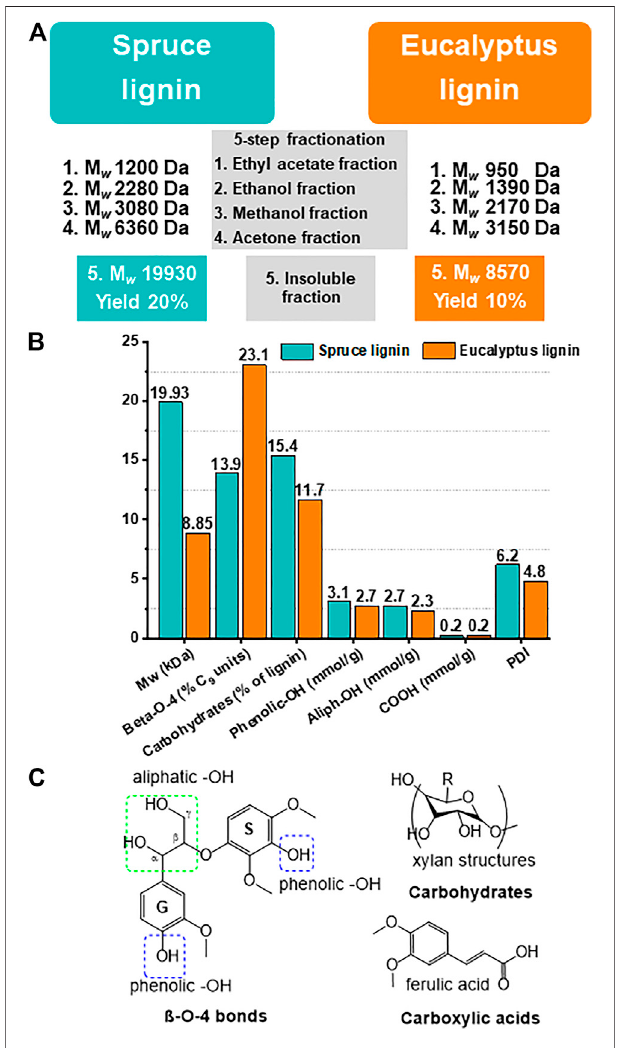
FIGURE 1 | The highest M w lignin fractions were used in this study to synthesize the LNPs. (A – C) The properties of kraft lignins and isolated fractions thereof used in this work. (A) Scheme of kraft lignin separation by M w using sequential 5-step solvent fractionation. The residual fraction with the highest M w obtained at the last fractionation step (insoluble fraction N5) wasused for LNP preparation. (B) AverageM w andpolydispersityindices(PDI)oftheresidualfraction ofspruceand eucalyptus lignin, as determined by size-exclusion chromatography (SEC).Thefunctionalgroup content, determinedby 31 PNMR, demonstratingthat both lignin types have relatively high aliphatic-hydroxyls (Aliph-OH) and low aromatic-OH content, as was determined (Tagami et al., 2019). (C) Depicted